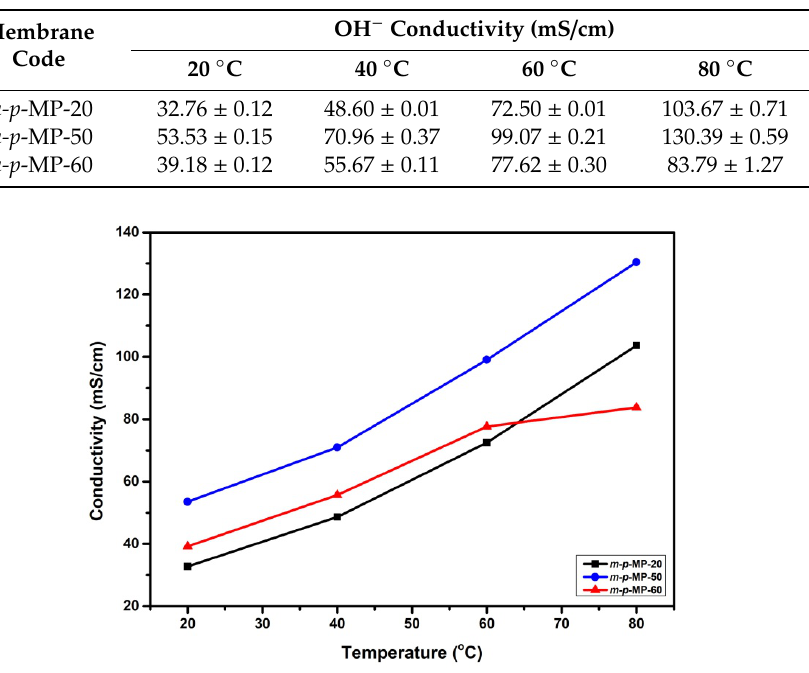
Figure 5. Conductivity profile for the anion exchange membrane (AEM) samples m-p -MP-20, m-p -MP-50, and m-p -MP-60.